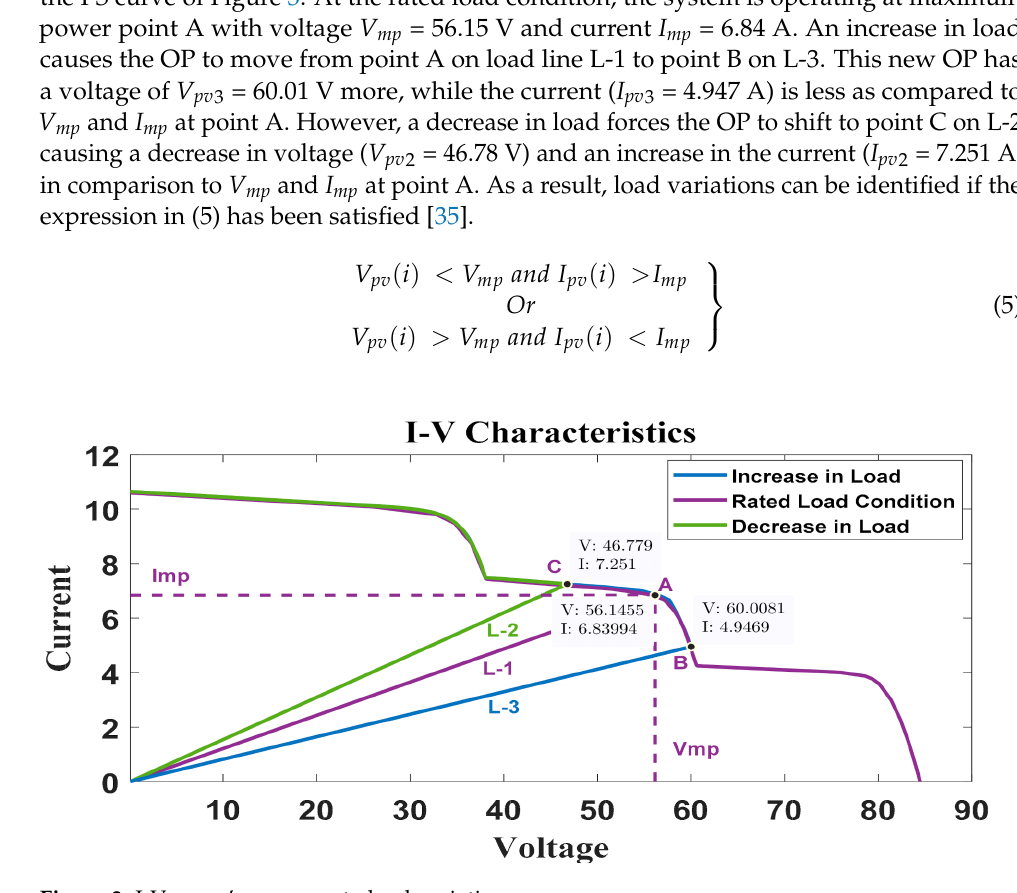
Figure 3. I-V curve’s response to load